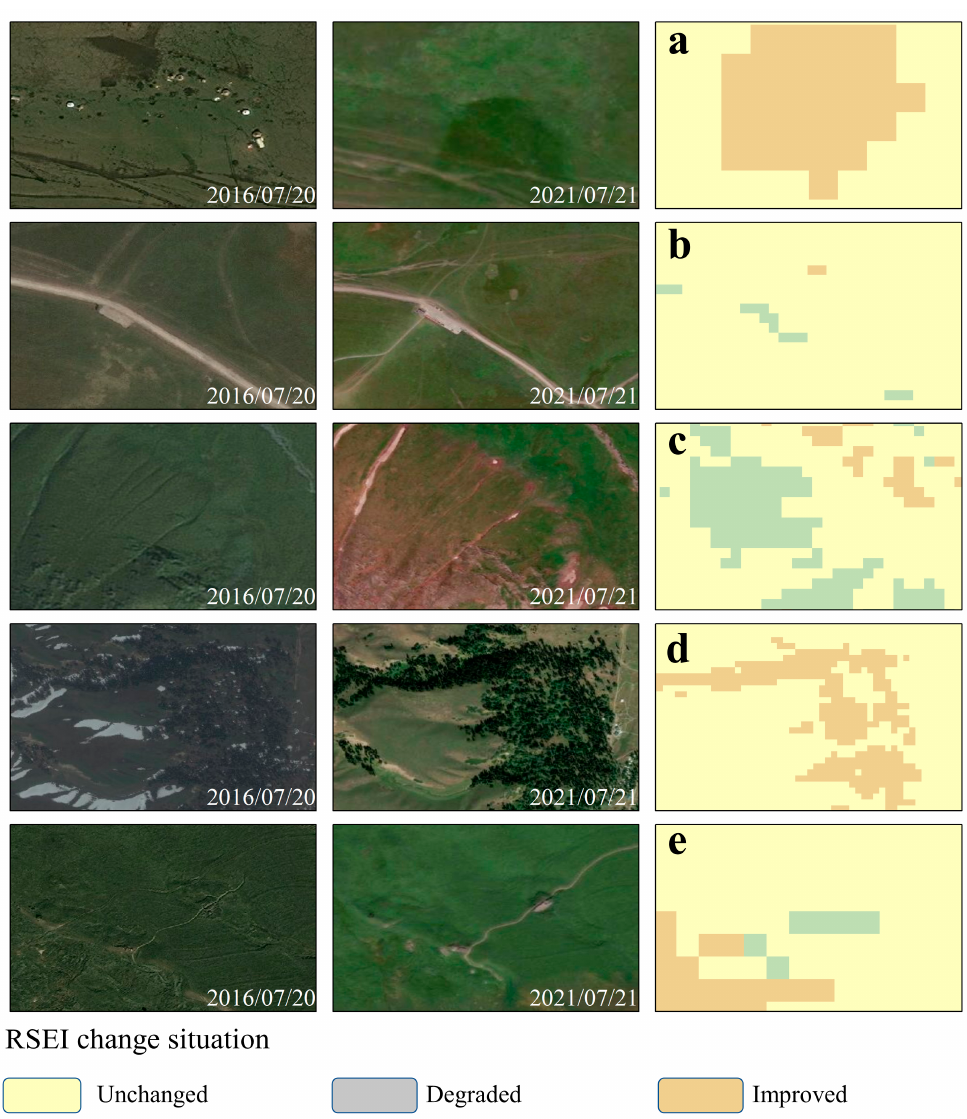
Figure 7. Case of comparative analysis of RSEI change images combined with World Imagery images. ( a , b , e ) Ecological changes in building and road areas. ( c ) Ecological changes in grassland areas. ( d ) Ecological changes in the forest area.